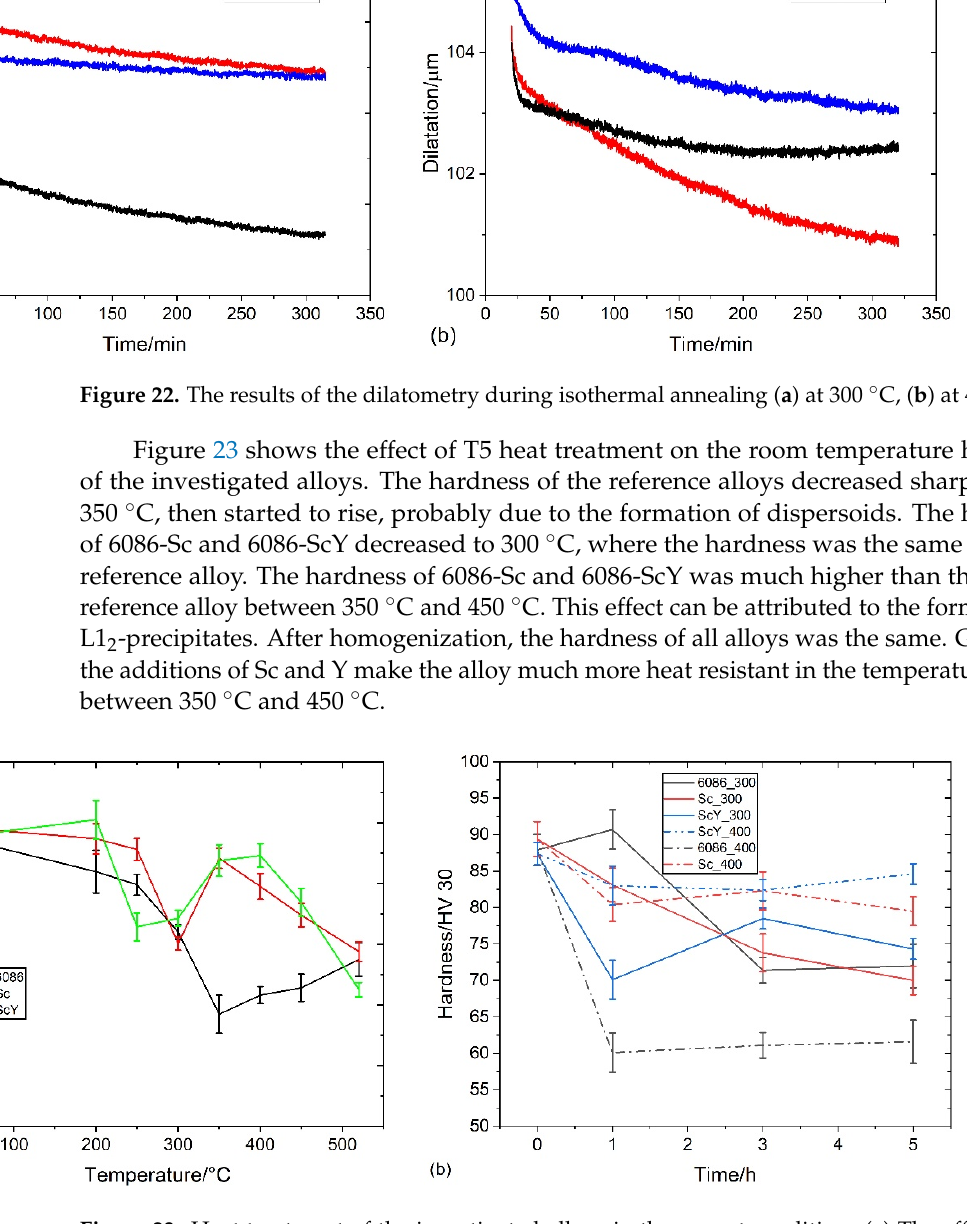
Figure 21. The results of DSC during isothermal annealing ( a ) at 300 °C, ( b ) at 400 °C.